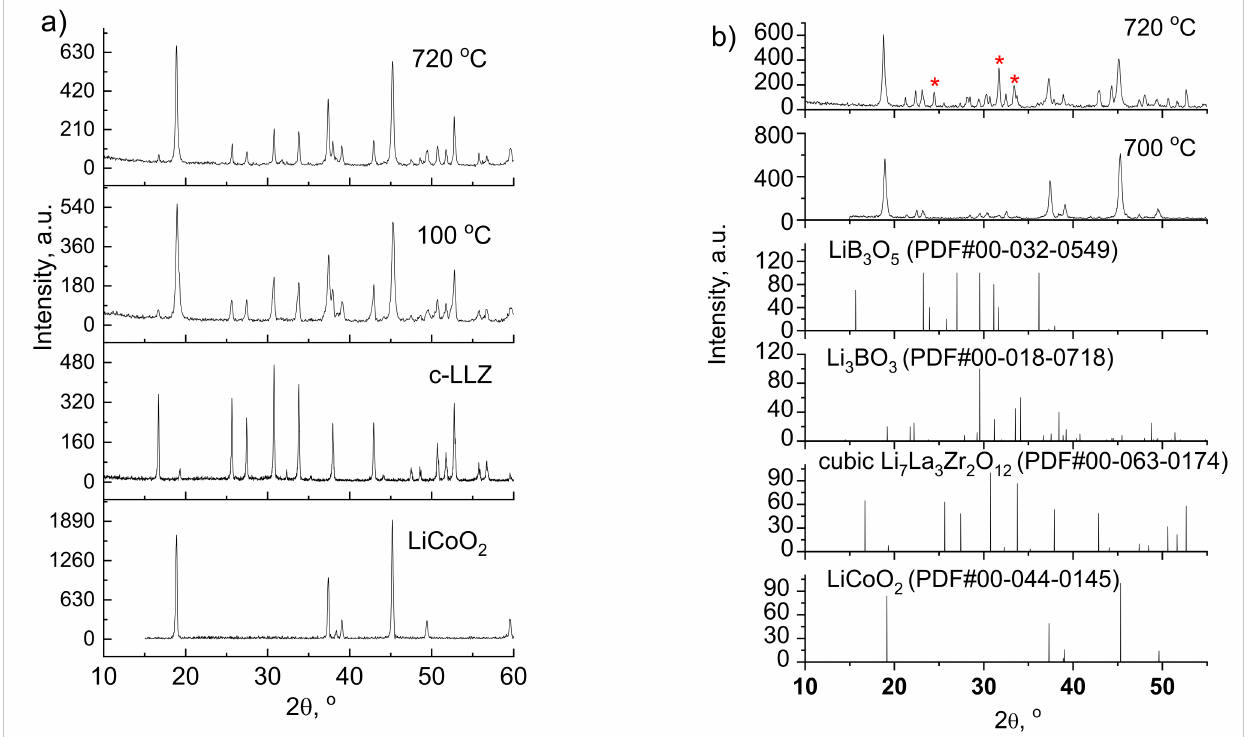
Figure 2. XRD patterns of LiCoO 2 ( a ) and LiCoO 2 + 5 wt%Li 3 BO 3 composite cathode ( b ) after sintering onto c-LLZ substrate at different temperatures. *—La 2 Li 0.5 Co 0.5 O 4